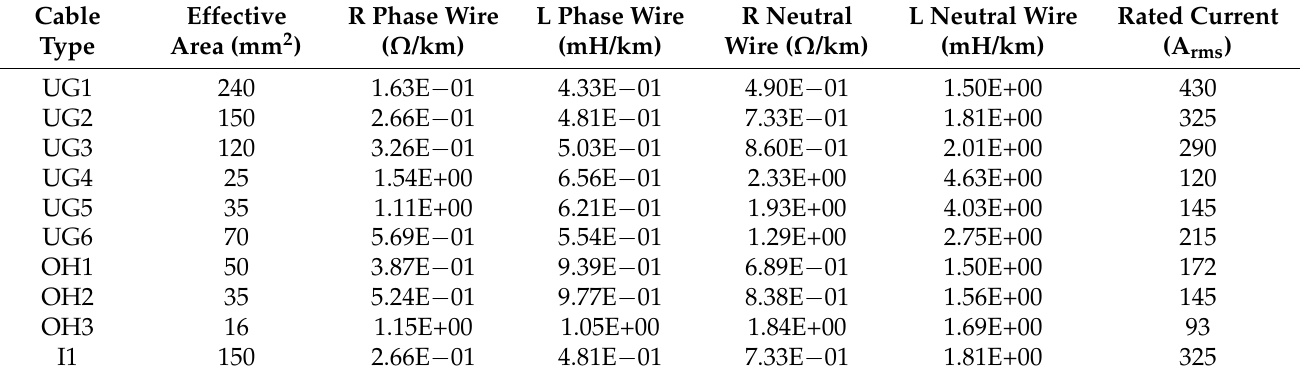
Table A1. Parameters of the cables used in the application example in Section